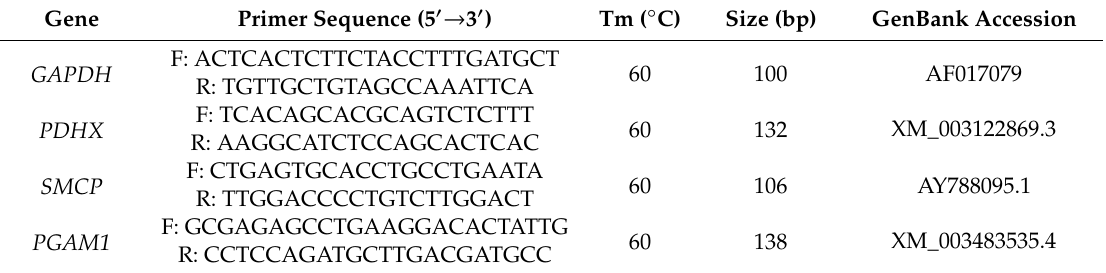
Table 1. Primers used for quantitative reverse transcription PCR